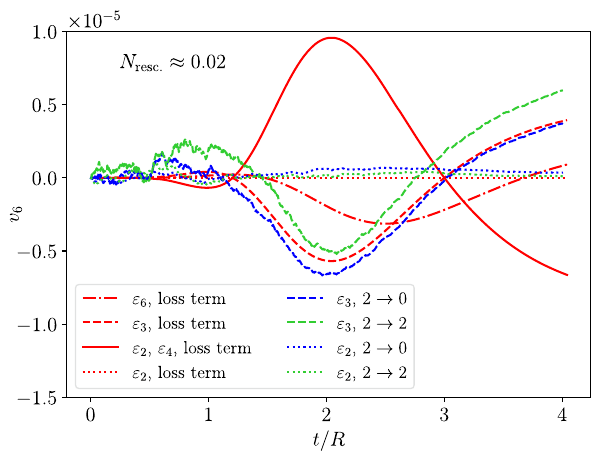
Fig. 9 Time dependence of hexagonal flow v 6 in systems with on aver- age N resc . ≈ 0 . 02 per particle and with different initial geometrical profiles, as described in the